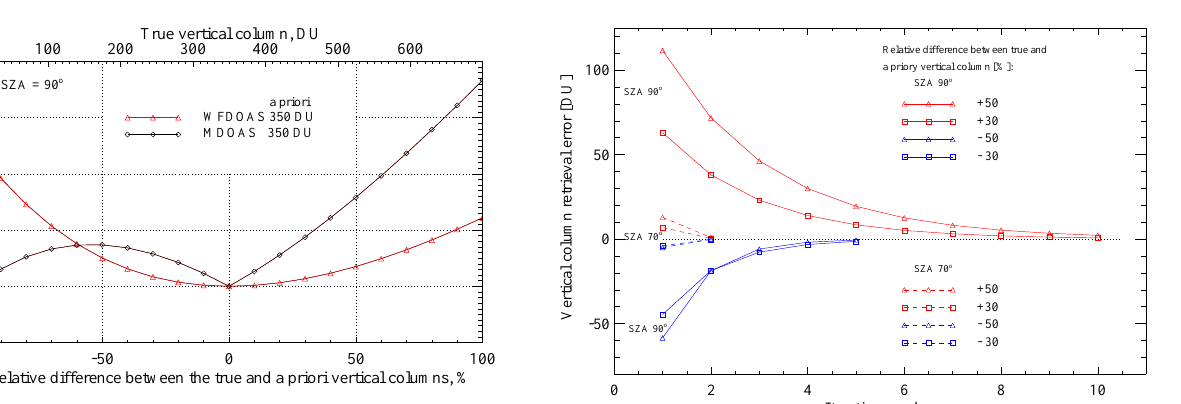
Fig. 7. Convergence rate of the iterative process according to Eqs. (124–126) for solar zenith angles of 70 ◦ (dashed lines) and 90 ◦ (solid lines). Symbols designate the retrieval errors obtained for se- lected percentage differences between the true and a priori vertical